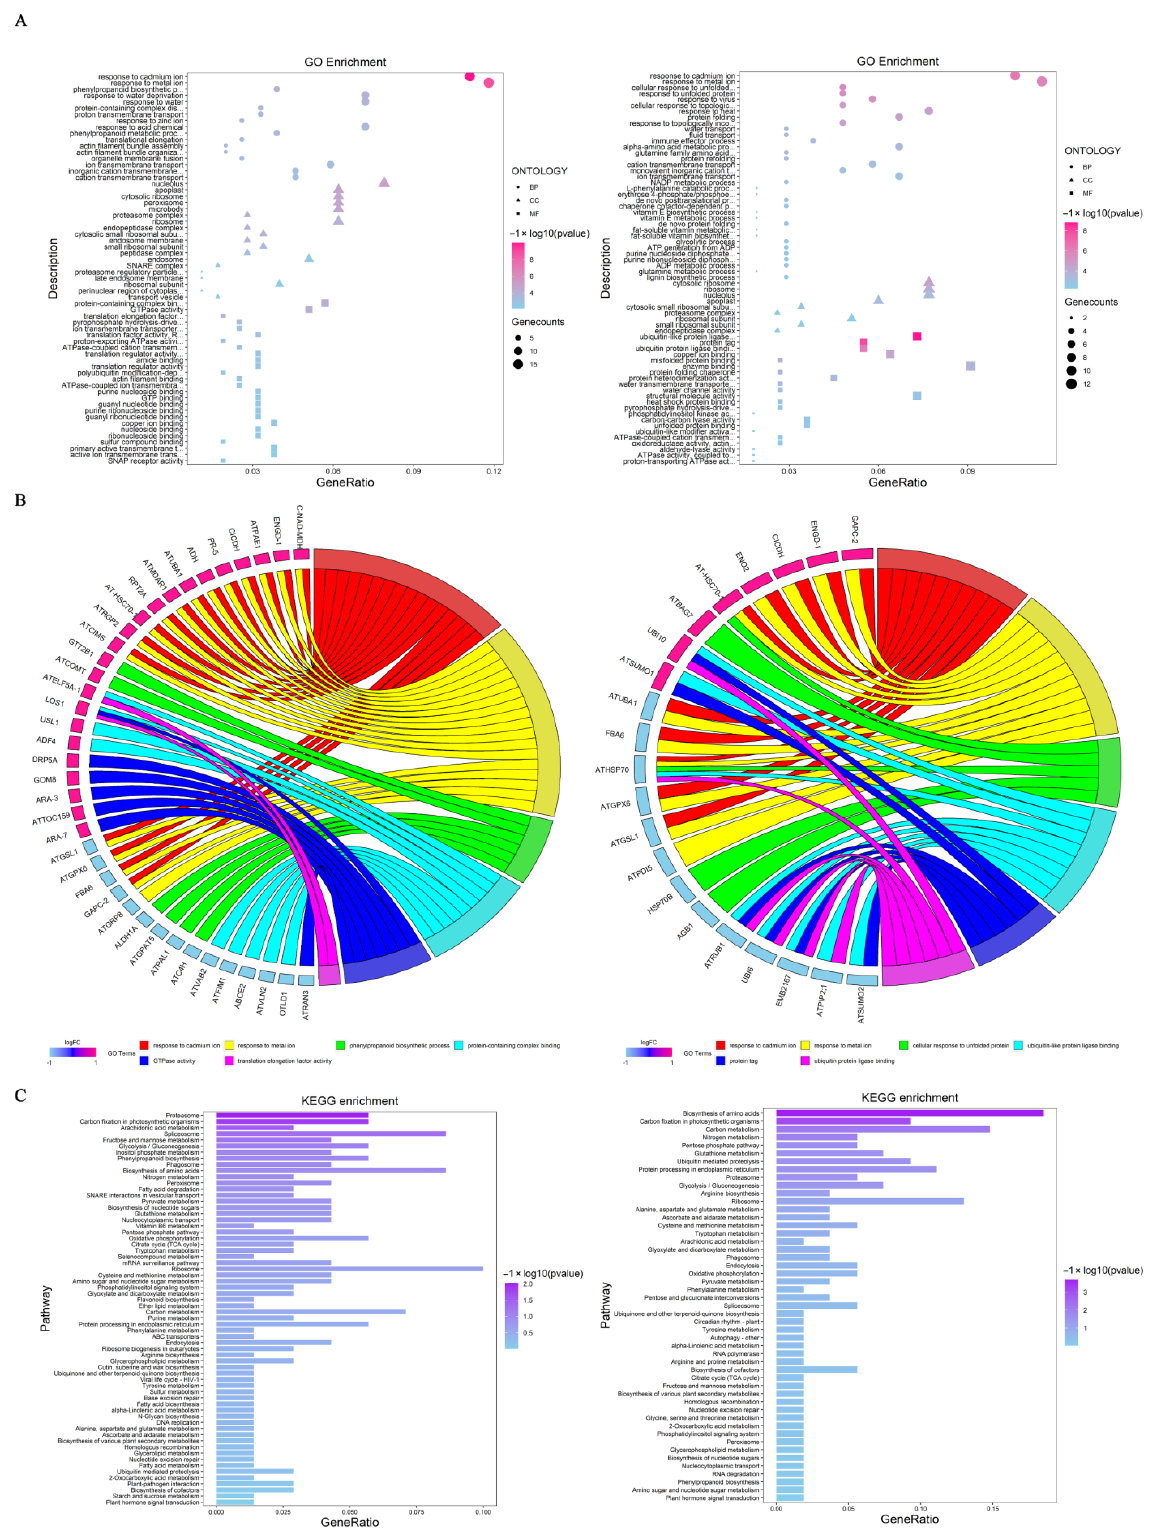
Figure 4. Bioinformatics analysis of the DEUPs. ( A ) GO enrichment bubble chart of the DEUPs (( left panel ), 200 mM NaCl; ( right panel ), 400 mM NaCl). See Table S6 for specific notes. ( B ) Ubiqui- tinated protein distribution of main enrichment pathways (pink, increased ubiquitinated proteins; blue, decreased ubiquitinated proteins). ( C ) KEGG enrichment of the DEUPs (( left panel ), 200 mM NaCl; ( right panel ), 400 mM NaCl). Refer to Table S7 for detailed